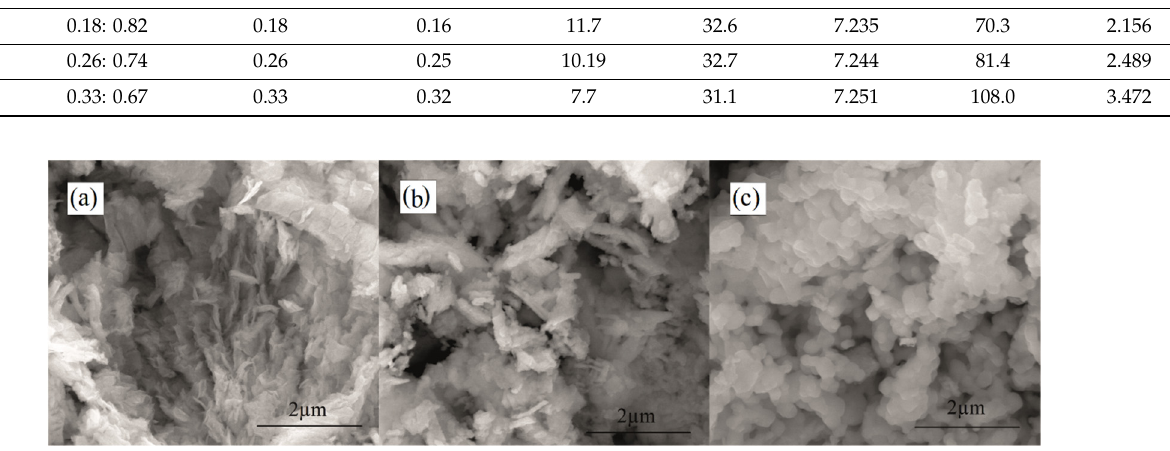
Figure 2. SEM images of 10-GDC ceramic powders calcined at ( a ) 800 °C, ( b ) 900 °C, and ( c ) 1200 °C for 5 h.